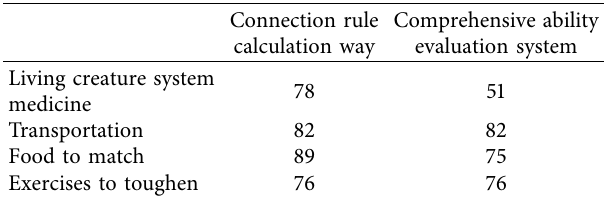
Table 2: Association rule calculation method and comprehensive ability use scoring table.